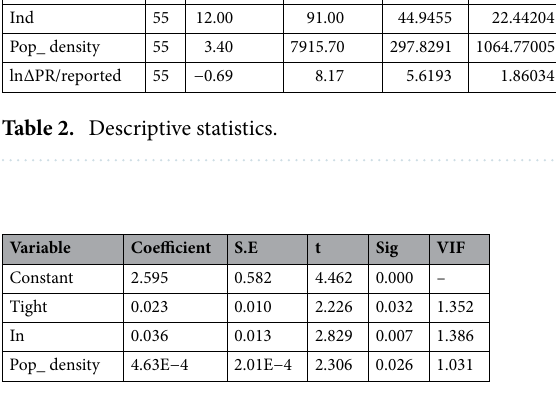
Table 3. Coefficients for linear regression equation.